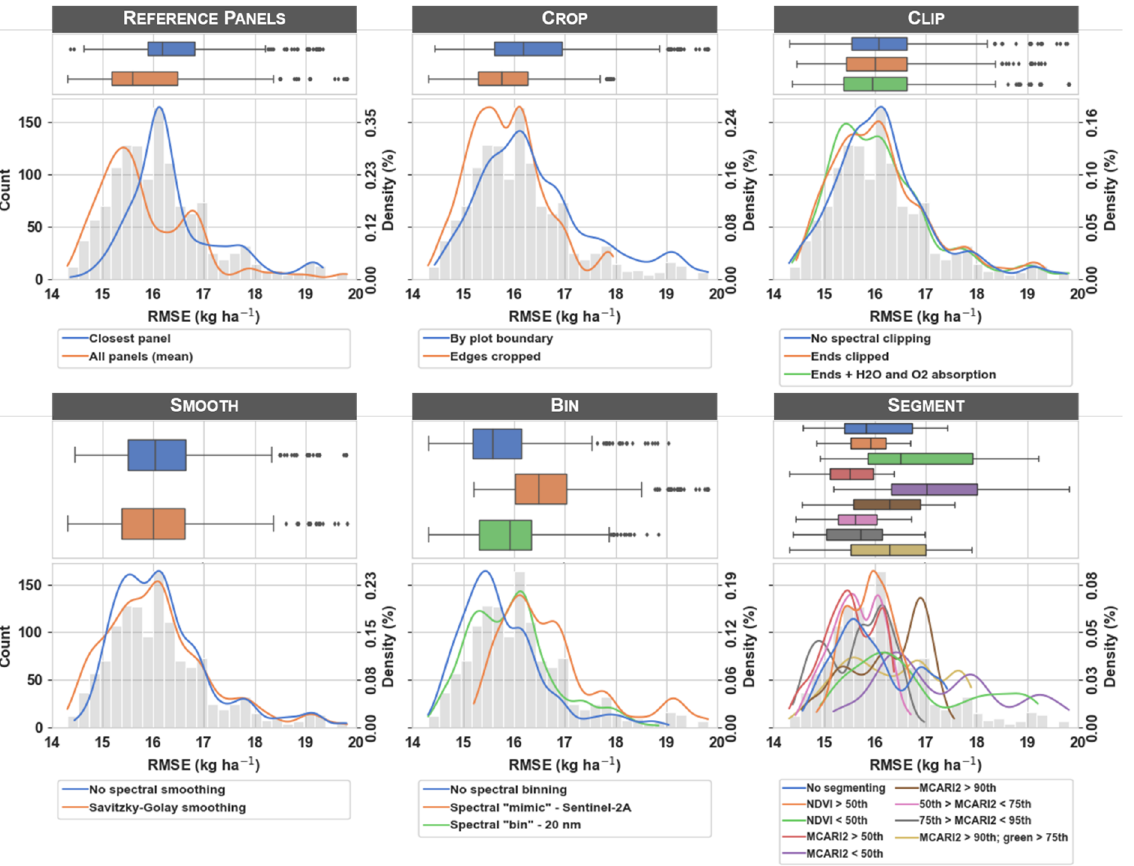
Figure 4. Box plots and density estimates of cross-validated root mean squared error (RMSE) values for the image processing steps evaluated in this study. At each processing step, the box plots and density estimates illustrate the first-order spread of error in predicted maize nitrogen uptake (kg ha − 1 ) for each of the processing scenarios evaluated (colors indicate the different scenarios within each image processing step). The grey histogram represents the distribution of RMSE values across all workflow scenarios and both estimators (included as a reference). Error values were calculated for each unique processing scenario based on lasso and partial least squares supervised regression estimators (RMSE n = 1296).